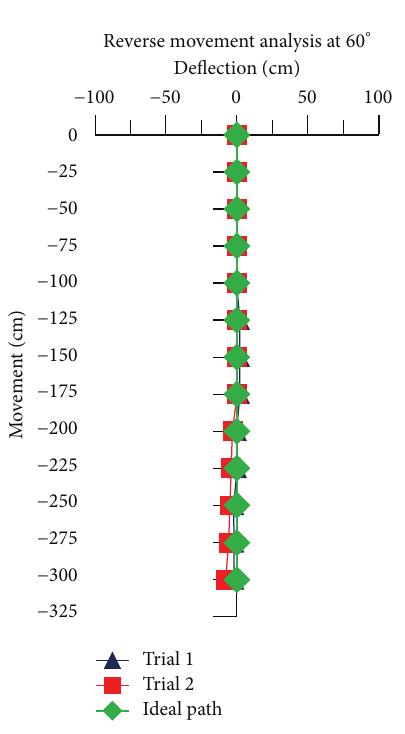
Figure 19: Reverse movement versus deflections at 𝜃 = 60 ∘